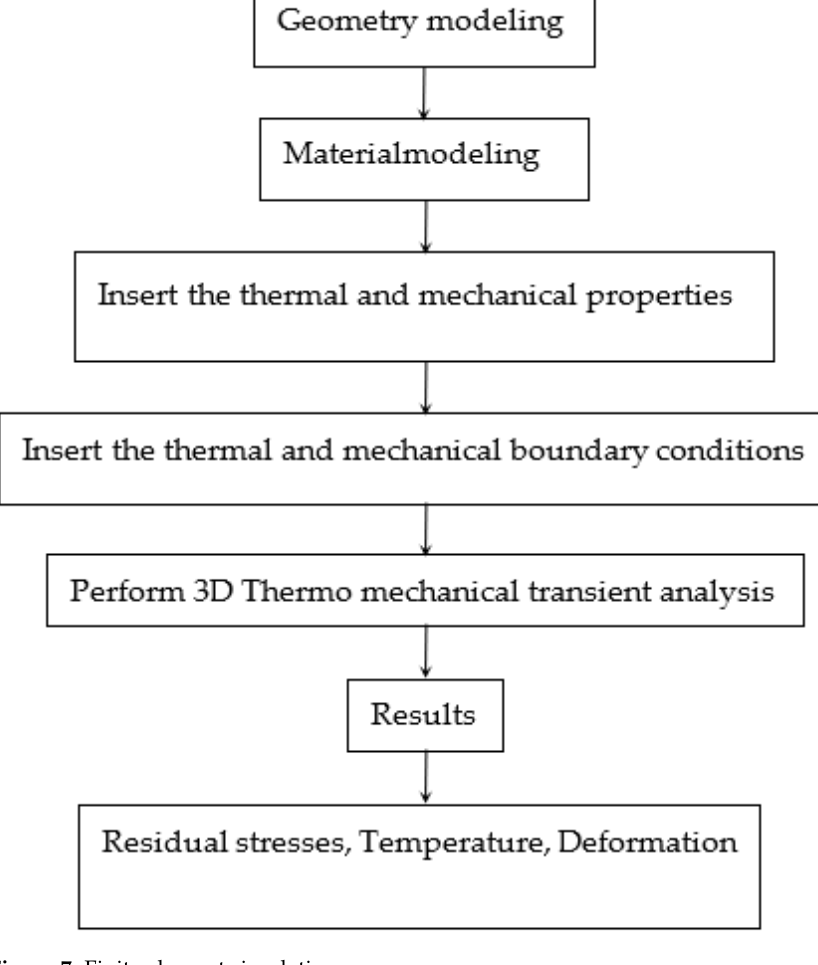
Figure 7. Finite element simulation process.